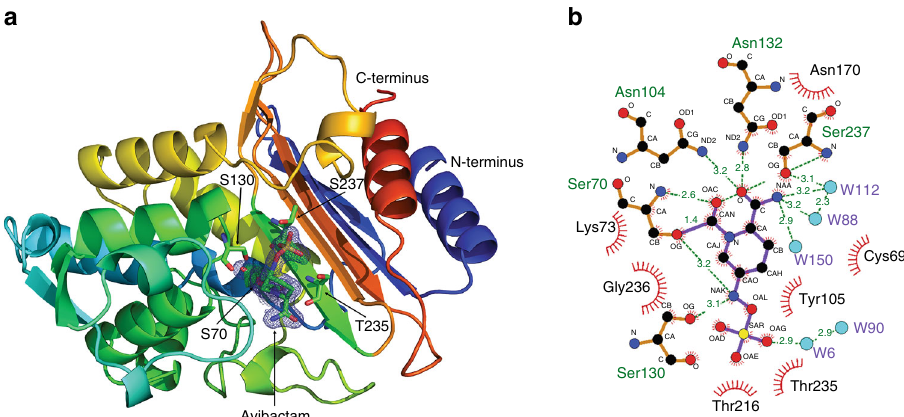
Fig. 6 Structure of CTX-M-14 β -lactamase determined by MHz SFX. a 2Fo-Fc map at 1 sigma overlaid on Fo-Fc map at 3 sigma around covalently bound avibactam from molecular replacement using a solvent-free version of the 5TWD β -lactamase structure from ref. 18 as the starting model. b Representation of covalently bound avibactam to OG of Ser70, stabilized by hydrogen bonds and hydrophobic interactions with surrounding amino acids of CTX-M-14. Figure was prepared using Ligplot